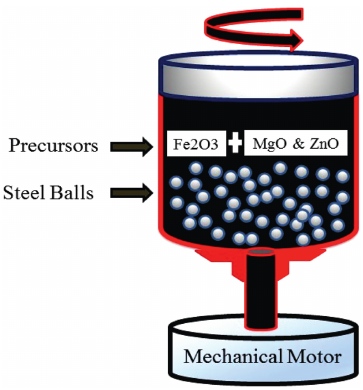
Figure 1: Schematic diagram of the planetary ball milling